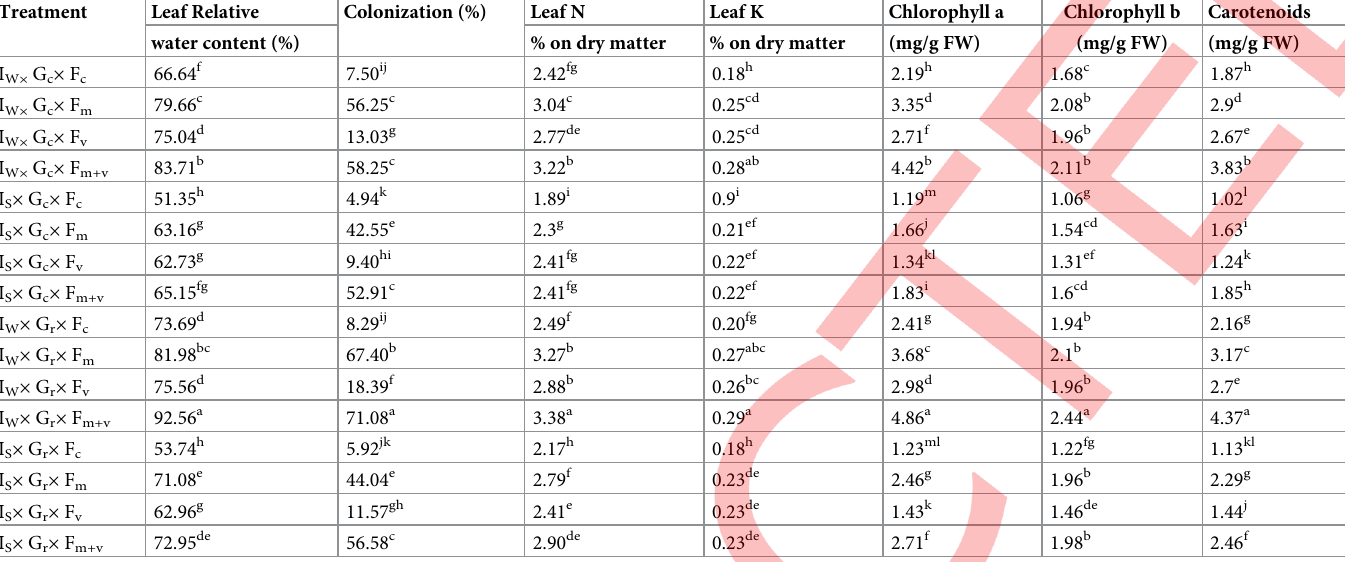
Table 3. Comparison between 2-year mean values of physiological traits of lingrain affected by green manure × mycorrhiza × vermicompost under full and limited irrigation. Treatment Leaf